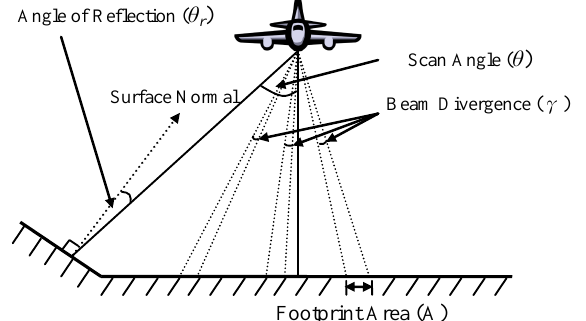
Figure 1. Illustration of the angle of reflection ( θ r )